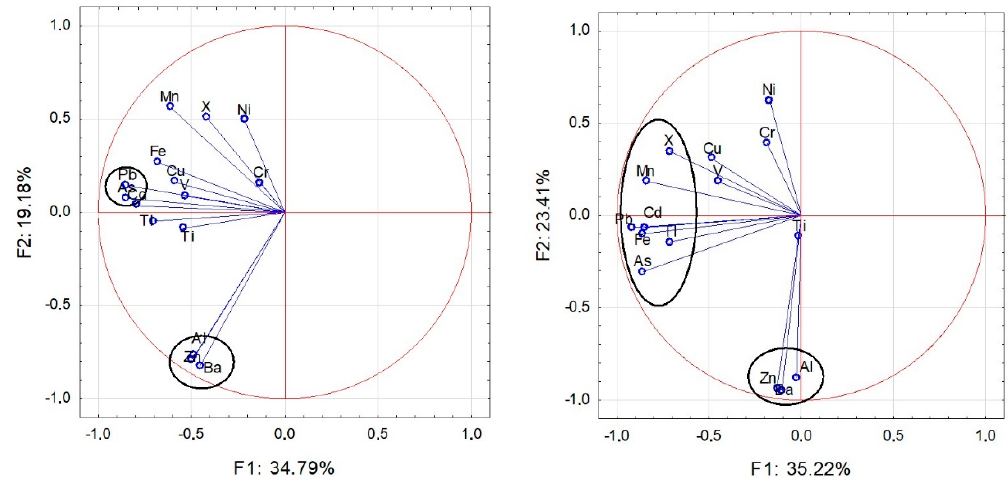
Figure 5. PC1 vs. PC2 biplot of the investigated elements in TSP ( left ) and PM1 ( right ).